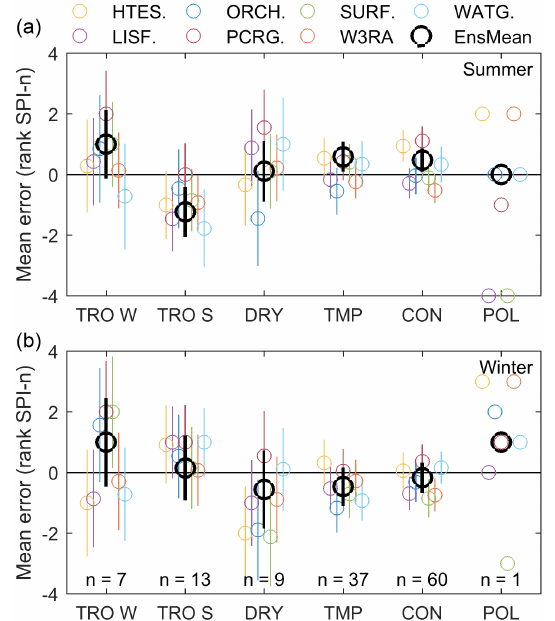
Figure 9. Mean error in rank SPI-n between model and observed summer (a) and winter (b) streamflow droughts. Error bars indicate the 95% confidence intervals of the mean, and the number of sites within each climate type group is indicated in the bottom